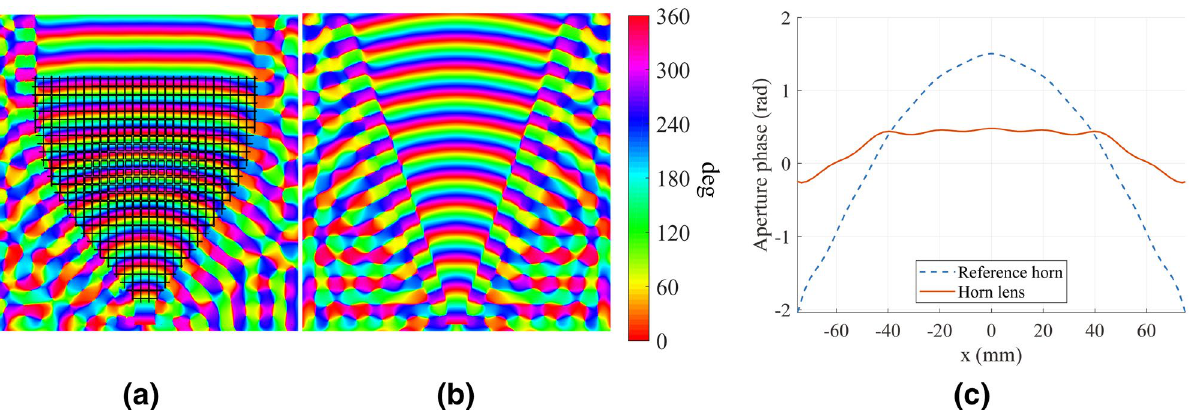
Figure 8. Simulated phase distribution of E z for the two H-plane antennas: ( a ) horn lens, and ( b ) reference horn. ( c ) Aperture phase comparison between the H-plane horn lens (solid red line) and reference horn (dashed blue line). The dimensions are L L = L H = 207 mm, W L = W H = 167 mm, H L = H H = 20 mm, and F L = 40